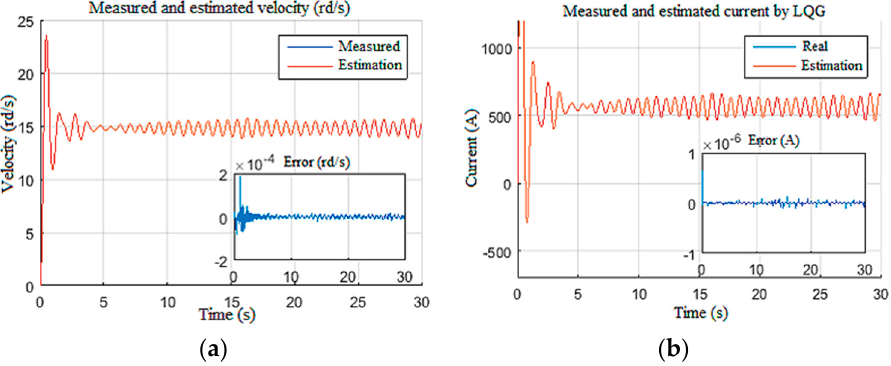
Figure 16. Top drive responses for Scenario 2: ( a ) velocity; ( b ) current.